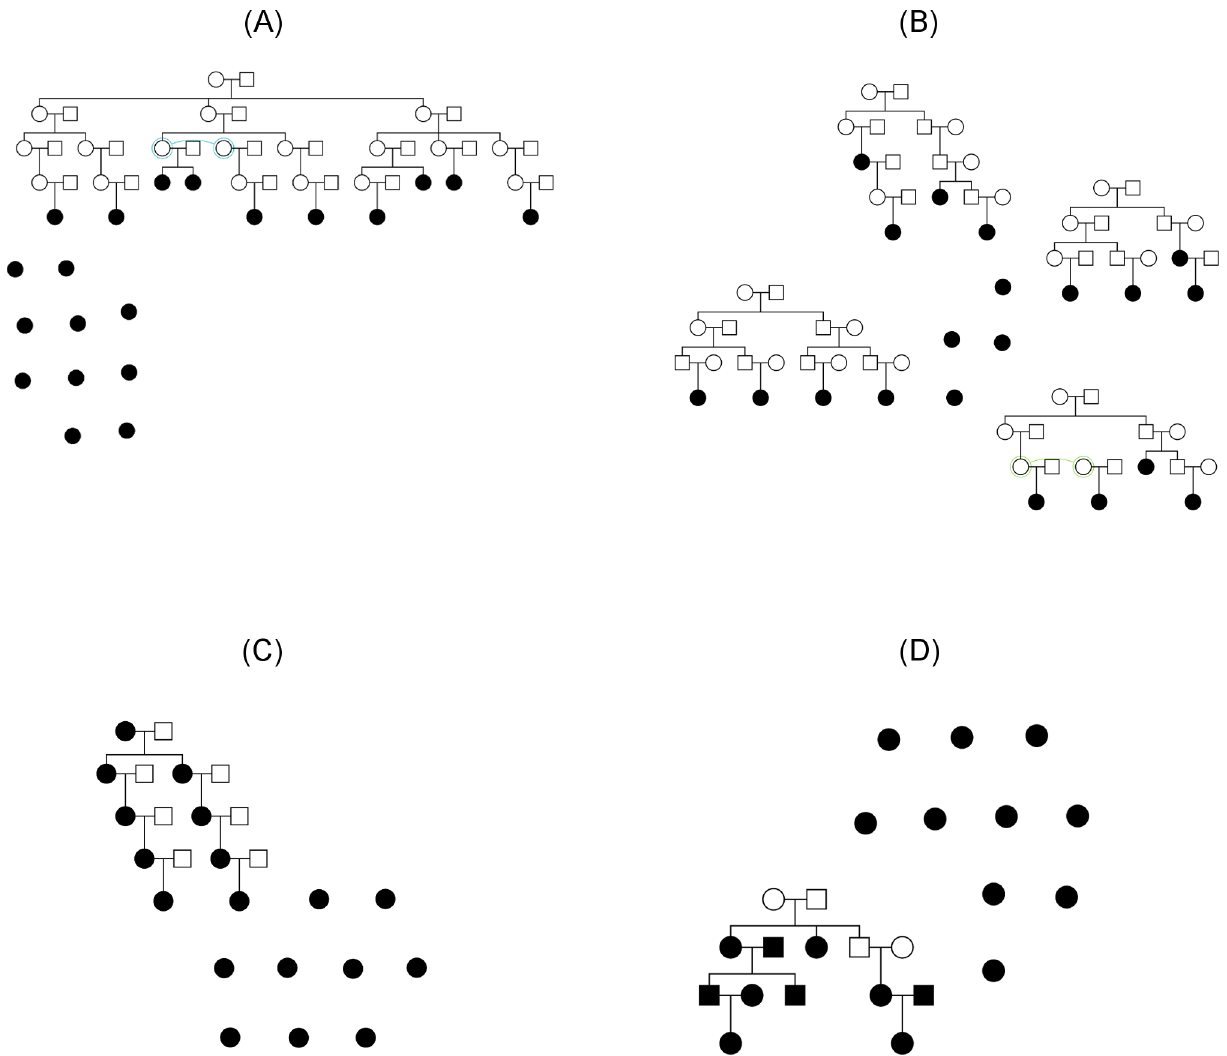
Fig 1. Simulated pedigrees. Shadednodesindicate sampledindividuals for which we have genotypedata and unshaded nodes indicate unsampledindividuals. (A) simulationA; (B) simulationB; (C) simulationC; (D) simulationD.